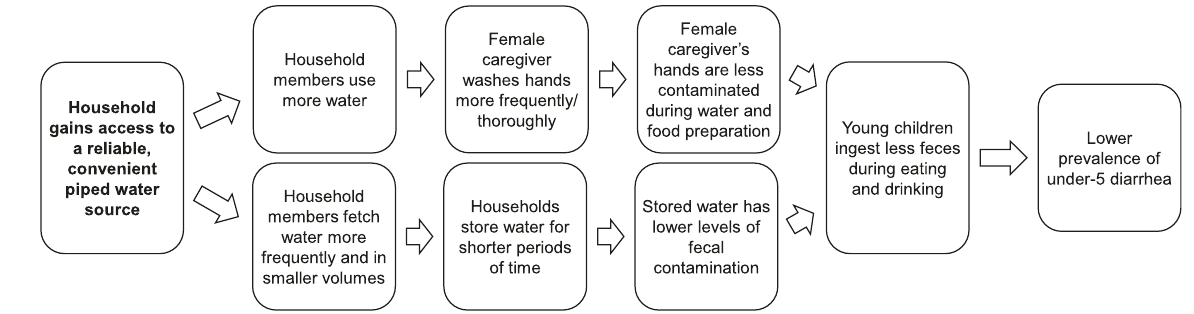
Fig. 1 Conceptual model. Hypothesized relationship between piped water access and key study